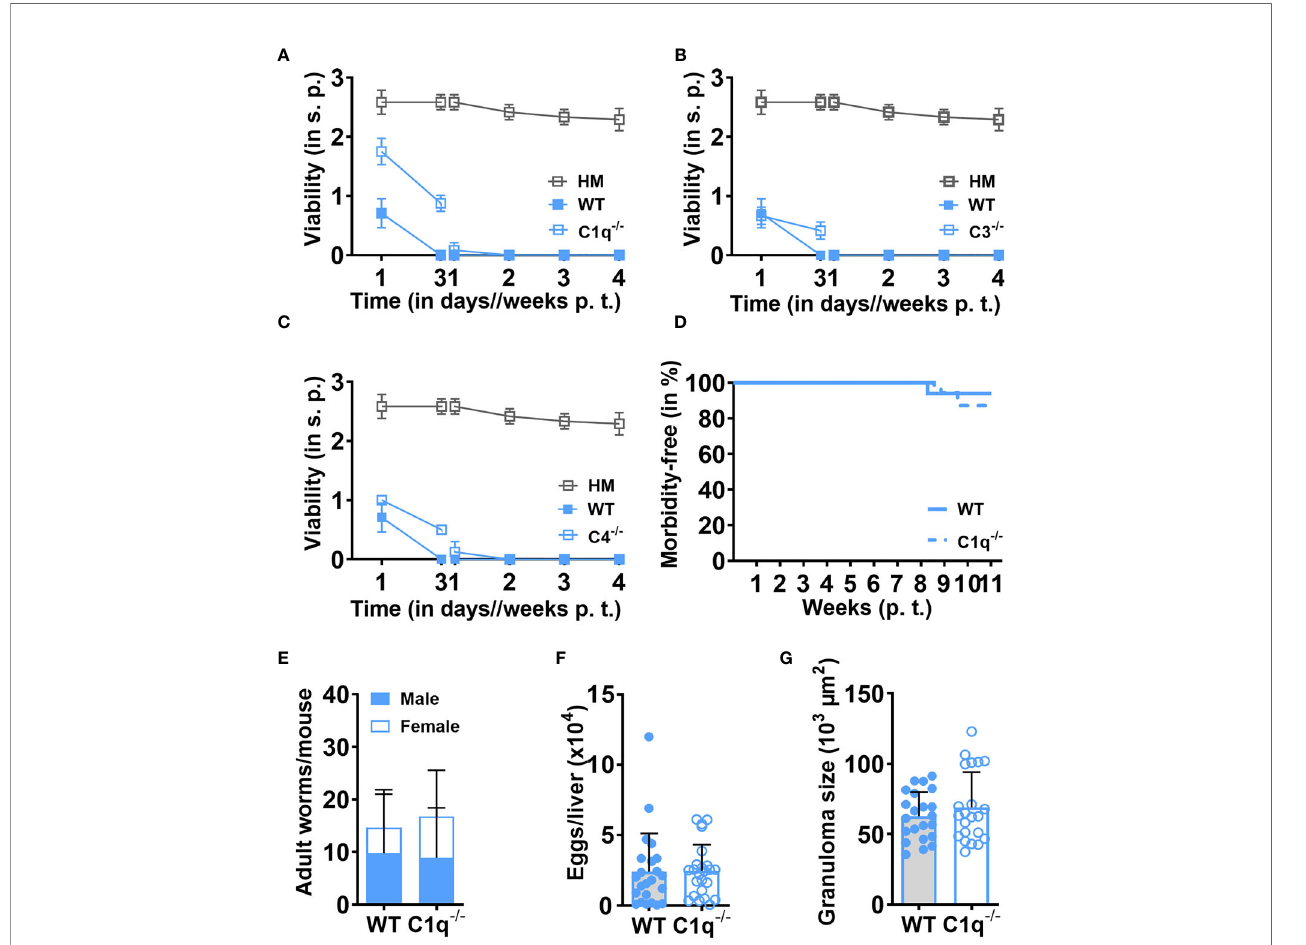
FIGURE 5 | Loss of C1q alters neither rapid killing of NTS nor in vivo maturation and immunopathology after S. mansoni infection. NTS were cultured and maintained using sera collected from (A) C1q -/- , (B) C3 -/- , (C) C4 -/- or wild-type (WT) mice and viability scoring was performed at the indicated time points. Hybridoma medium (HM) alone was used as a control. Results are representative of at least three individual experiments. Each data point has been shown as mean ± SD of at least three technical replicates. (D) Loss of C1q does not signi fi cantly in fl uence the mortality of S. mansoni -infected mice. C1q-de fi cient mice were infected by injecting 200 cercariae subcutaneously and survival of the animals was monitored on a weekly basis. (E) Worm maturation was not affected by the de fi ciency of C1q. After nine to 11 weeks of infection, the animals were euthanized and mature worms from mesenteric veins were fl ushed out, enumerated and male/female ratio was determined. (F) Lack of C1q does not affect the fecundity of the worm. Animals were infected and euthanized, and eggs from a weighted liver were isolated and counted. (G) C1q does not in fl uence the egg-induced immunopathology of the worm. Liver sections (4 µm) from infected wild-type or C1q -/- mice were stained with Masson ’ s Blue and the diameter of 30-40 granuloma/section was measured under microscope (10x). Data shown is pooled data from fi ve individual experiments (WT, n=28; C1q -/- , n=34). Each data point shows a single mouse. Mean ± SD is indicated with bars. p. t., post transformation; s.p., scoring